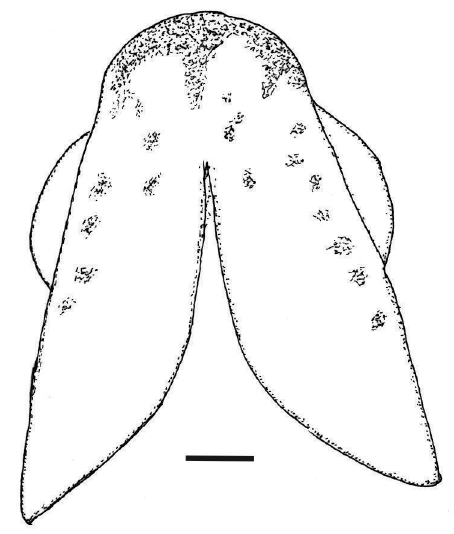
Figure 9. Diagrammatic representation of the colour pattern on the ventral surface of the head in females of Melanorivulus regularis , UFRJ 6879, 28.5 mm SL. Scale bar: 1 mm.